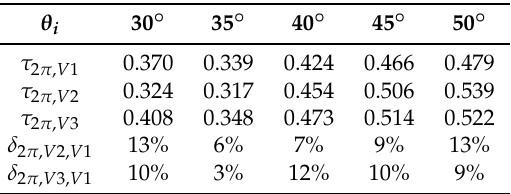
Table 2. Conical-hemispherical transmission for measurements τ 2 π , V 1 and simulation results τ 2 π , V 2 and τ 2 π , V 3 .